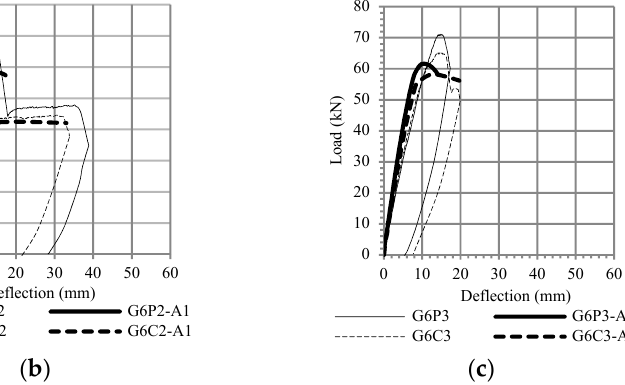
Figure 11. Comparison between test results and the fiber element method (RCCSA) ( a ) reinforcement ratio 1%, ( b ) reinforcement ratio 1.5%, and ( c ) reinforcement ratio 2.5%.